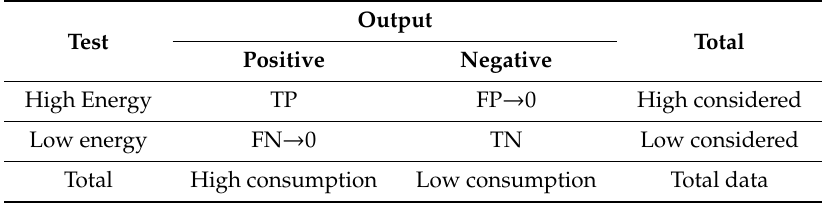
Table 2. Output and Test for electricity consumption.